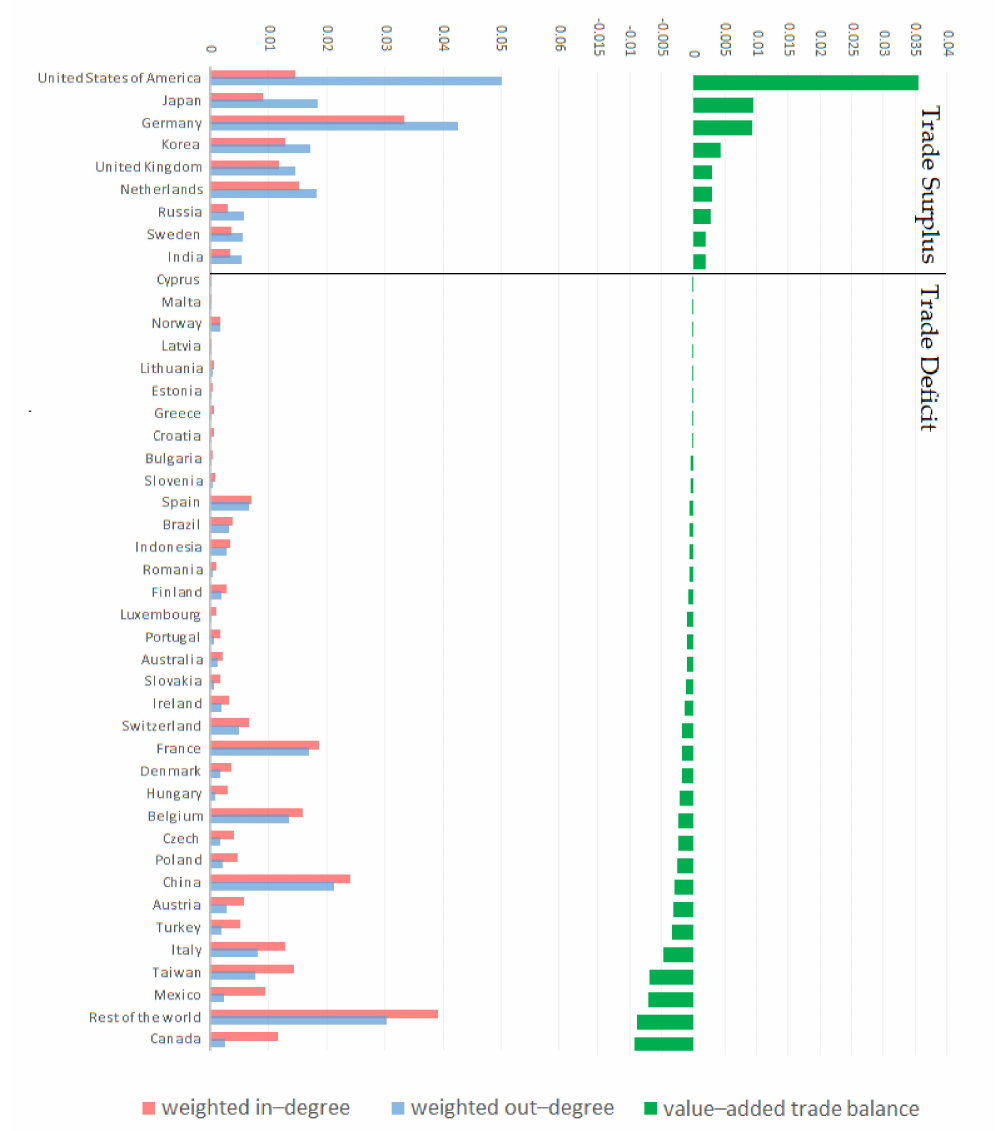
Figure 2. Sectoral GVC network: “Manufacture of chemicals and chemical